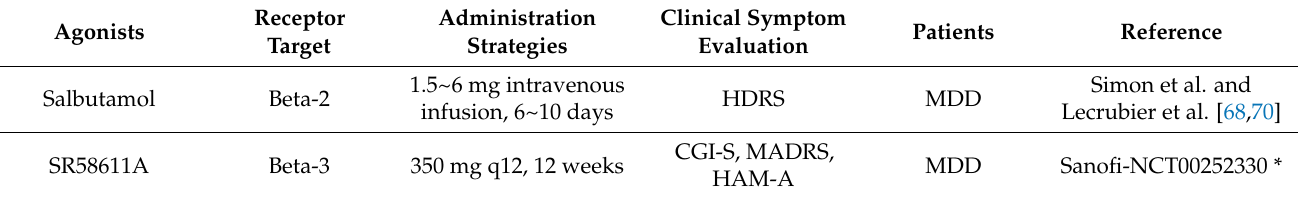
Table 4. Beta-adrenoceptor agonists tested in human studies.